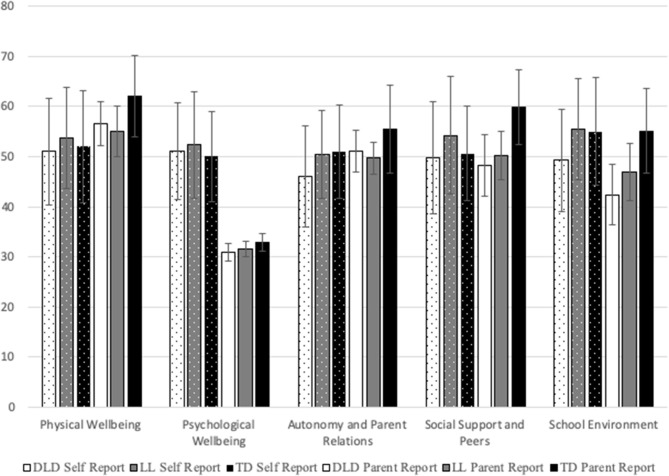
Mean T-scores across each dimension of the KIDSCREEN-27 according to self and parental report. Error bars reflect standard deviation.